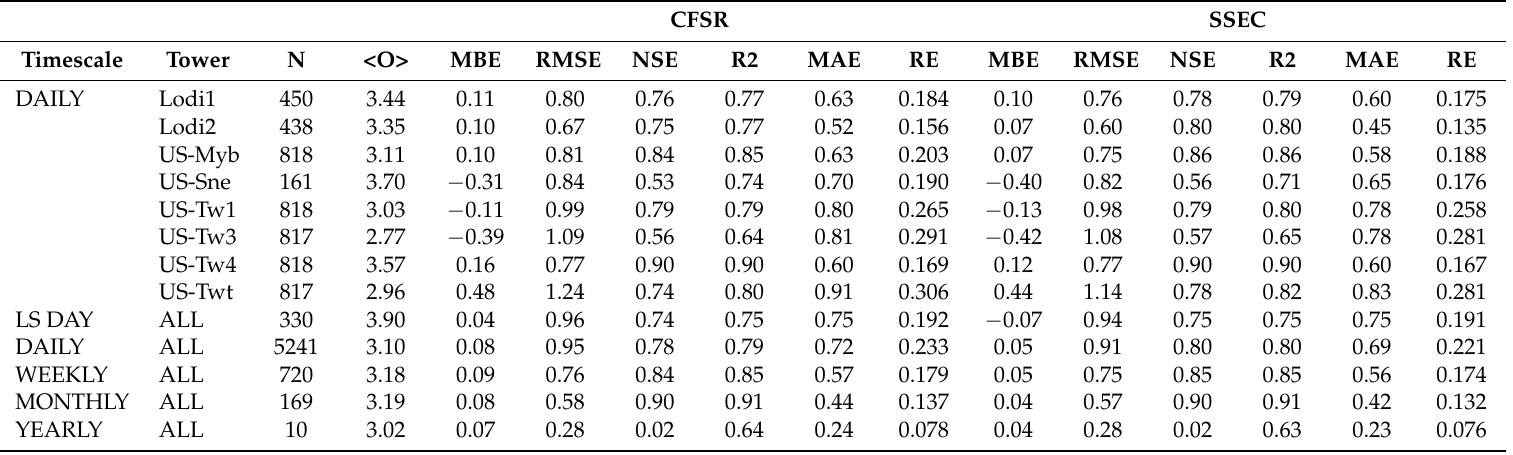
Table 3. Statistical metrics of ET retrieval performance (mm d − 1 ) at flux sites on clear Landsat overpass dates (LS Day) and at daily, weekly, monthly, and yearly timesteps using insolation inputs from the CFSR and SSEC